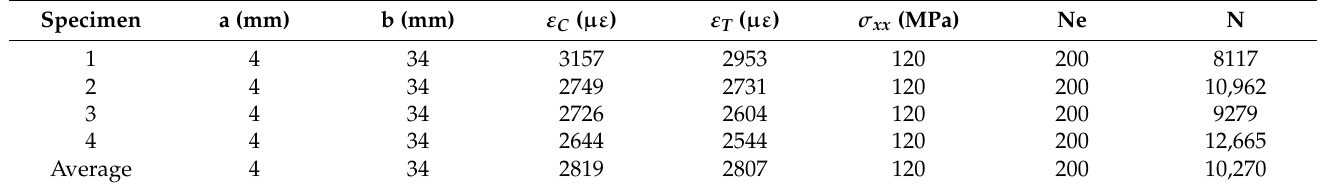
Table 1. The four-point bending fatigue test and initial strains as a function of the stress state. Specimen